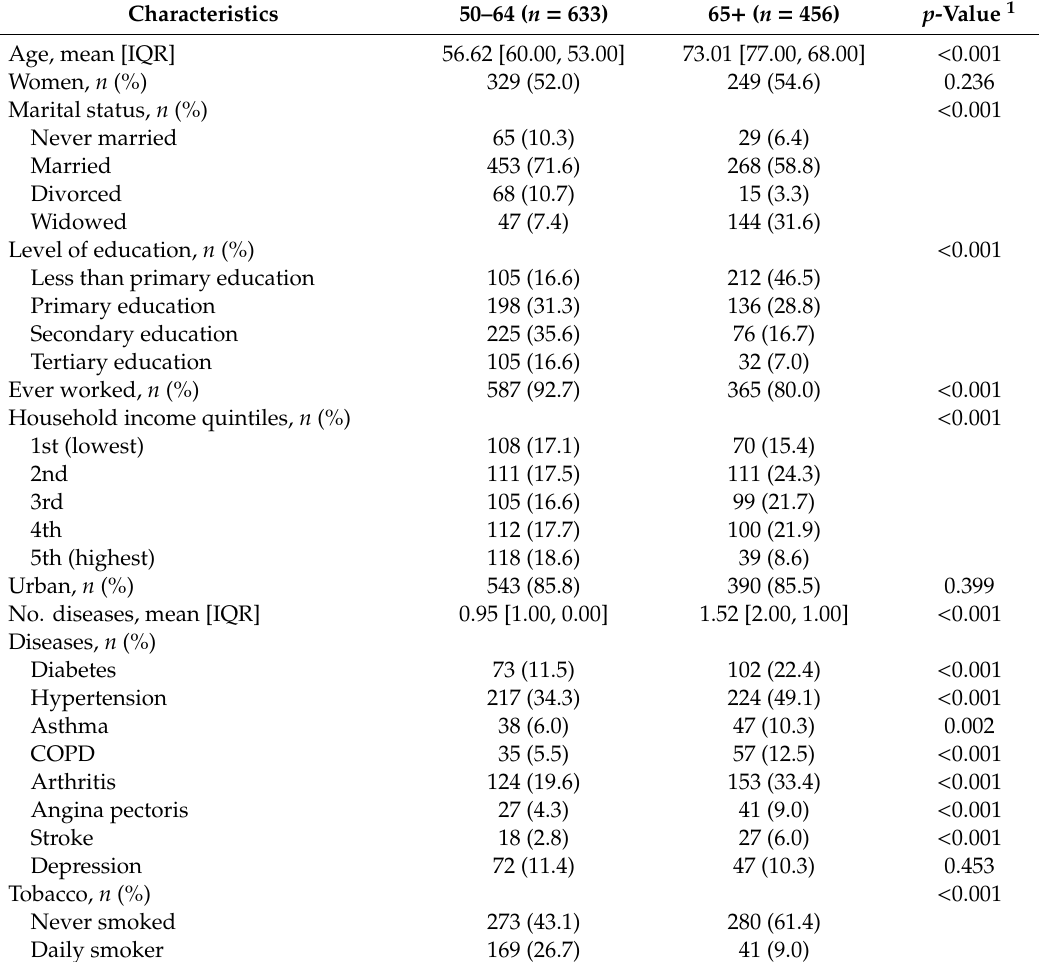
Table 1. Baseline characteristics of the sample by age category ( n =